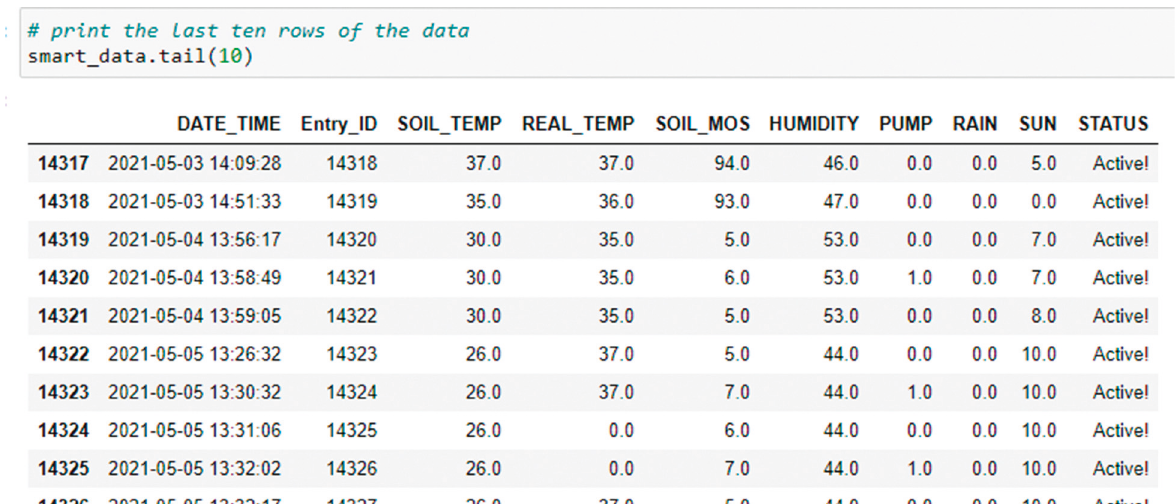
Figure 9: The last 10 rows of the